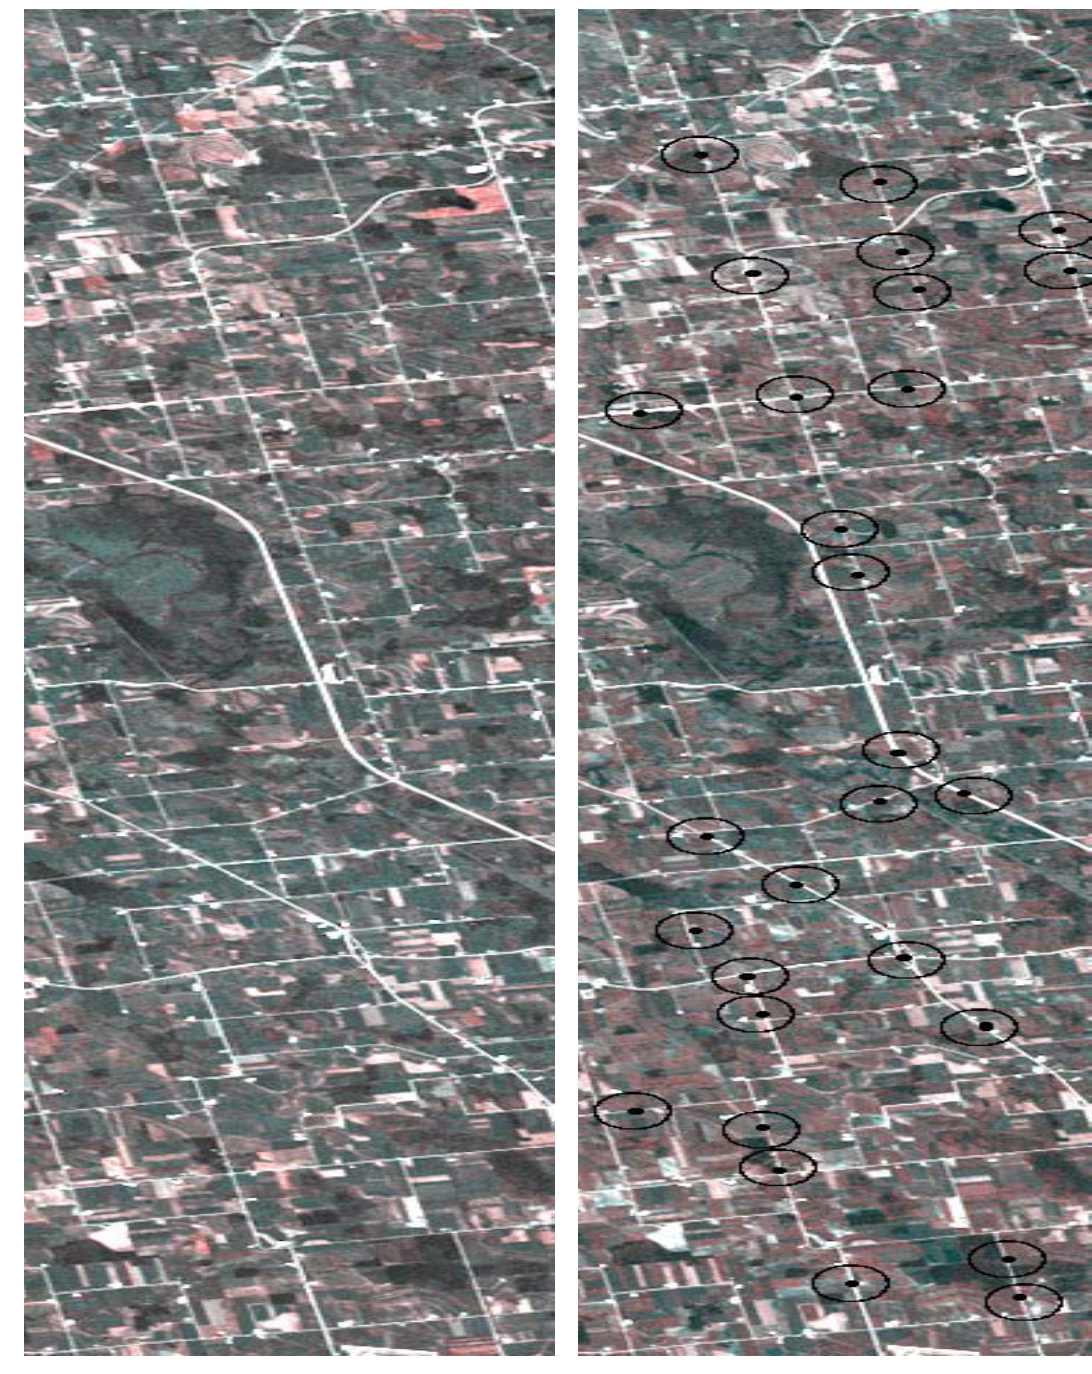
Figure 4. Marked samples of training sets for Milwaukee highways and roads in bands 1, 2, and 3. The scene ID #: Y5013916033x07. Left image is the corrected; the right image is the uncorrected one. The marked training samples were classified and results are shown in Tables 1A-1C and Tables